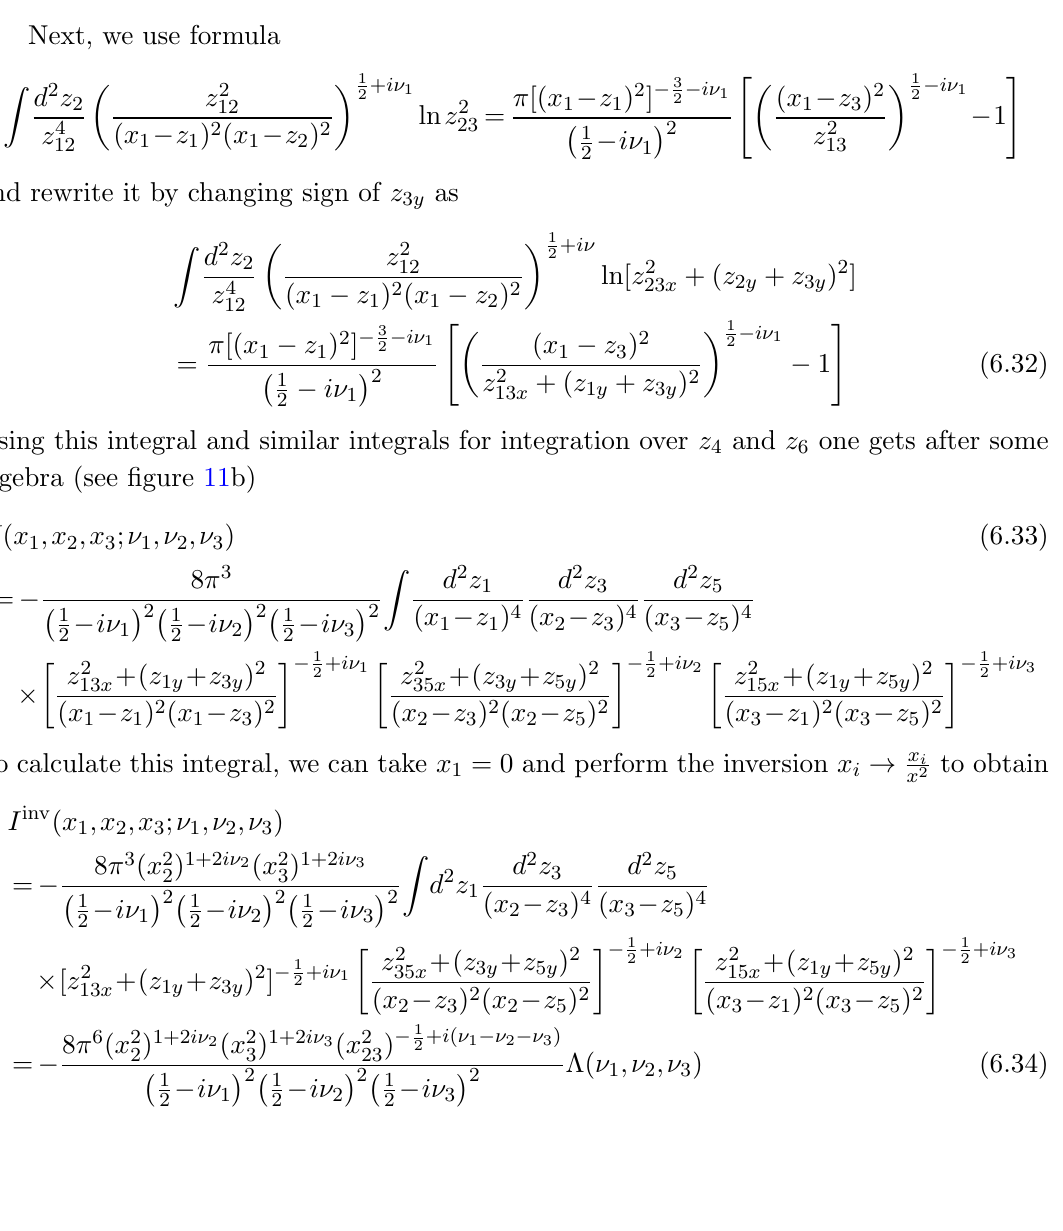
+ ( z i + z j ) 2 ] (cid:21) x y